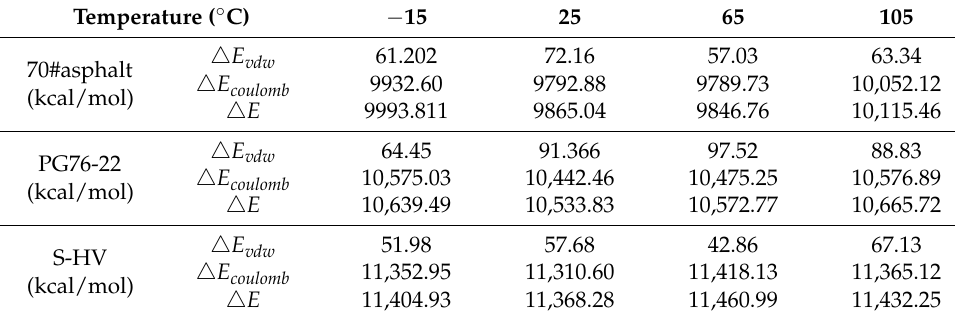
Table 4. Adhesion work between three asphalt types and C-S-H